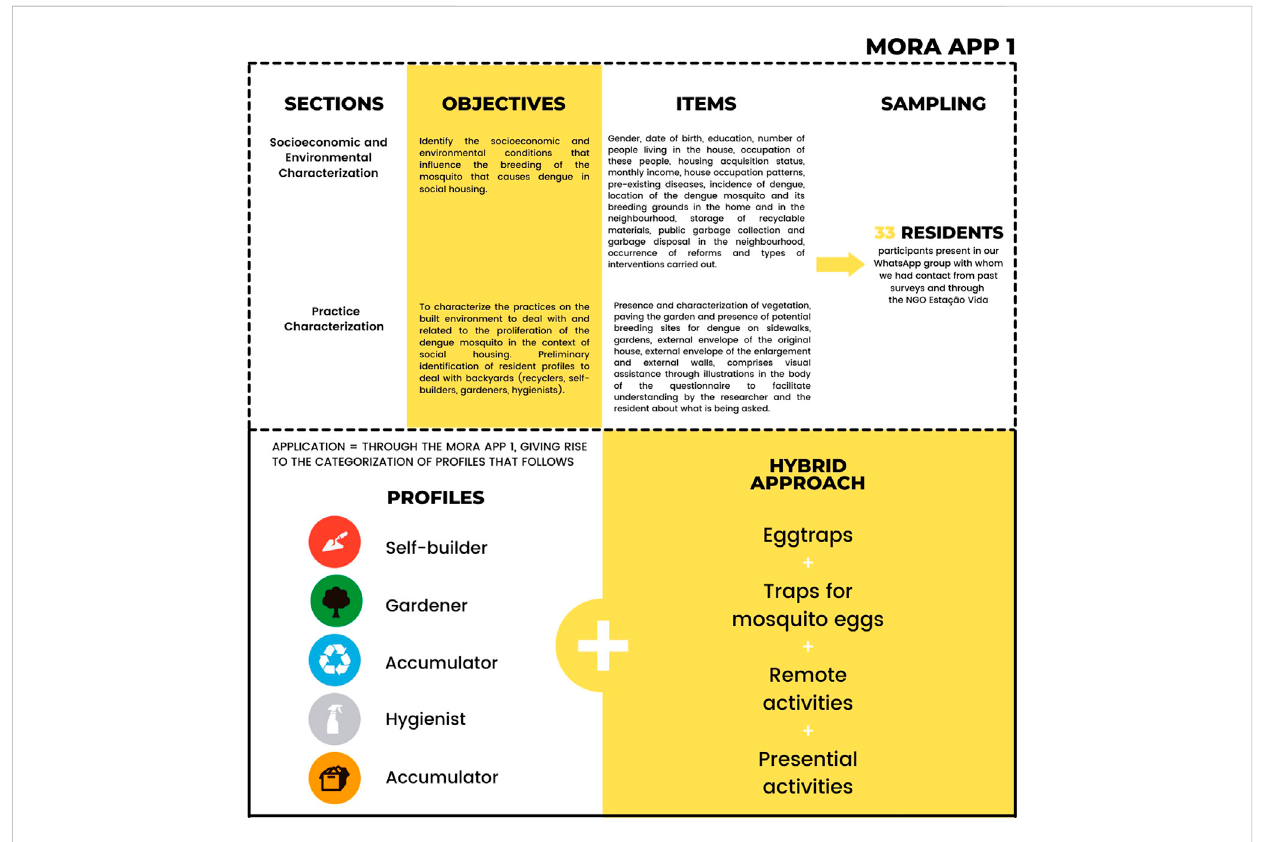
FIGURE 3 Mora App 1 questionnaires and output